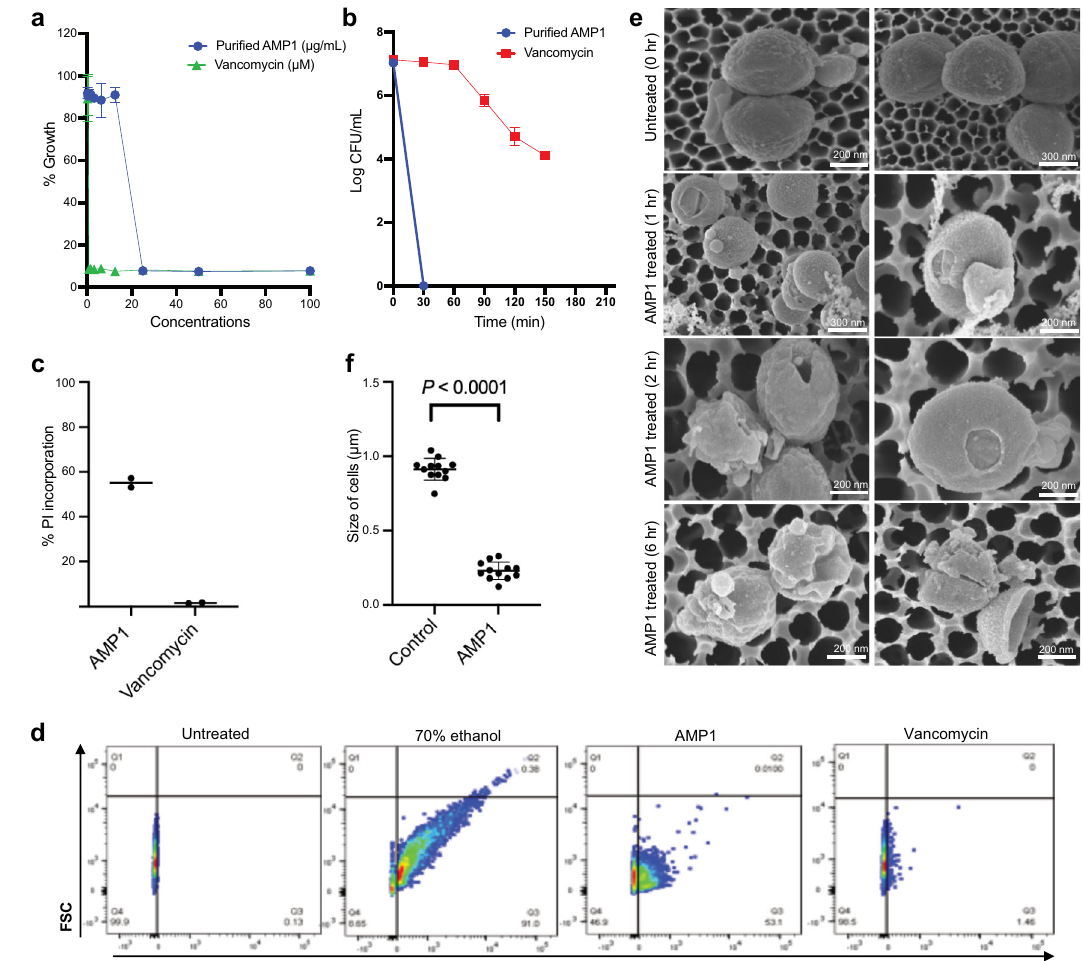
Fig. 5 | Plant-puri fi ed peptide AMP1 causes rapid membrane permeabilization and killing of MRSA USA300. a Antimicrobial activity (expressed as a minimal inhibitory concentration [MIC] of plant-puri fi ed AMP1 and vancomycin, evaluated against10 6 CFU/mLofMRSAUSA300.MICforppAMP1was~25 µ g/mLintrypticsoy broth; MIC for vancomycin was 0.7 µ M (±SD, n =3 independent experiments). b, c Killing kinetics (b) n =3 independent experiments and in fl ux of propidium iodide dye(c)asmeasuredby fl owcytometry.Thecontrolsusedwereasfollows:x-axis,0 = no antimicrobialactivity; MRSAUSA300 exposed to 70%ethanol is equivalent to 100% killing or in fl ux of PI dye; and cell-wall biosynthesis inhibitor vancomycin